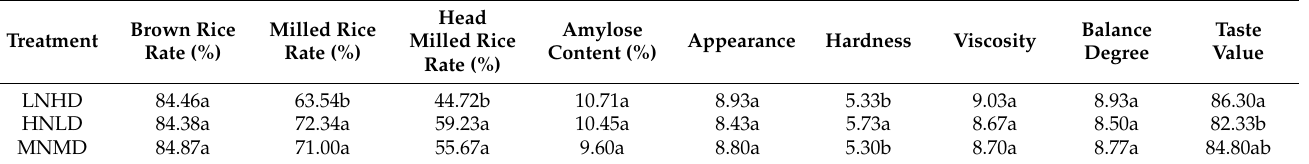
Table 1. Differences in taste value, processing quality, and amylose content of rice under different nitrogen fertilizers and